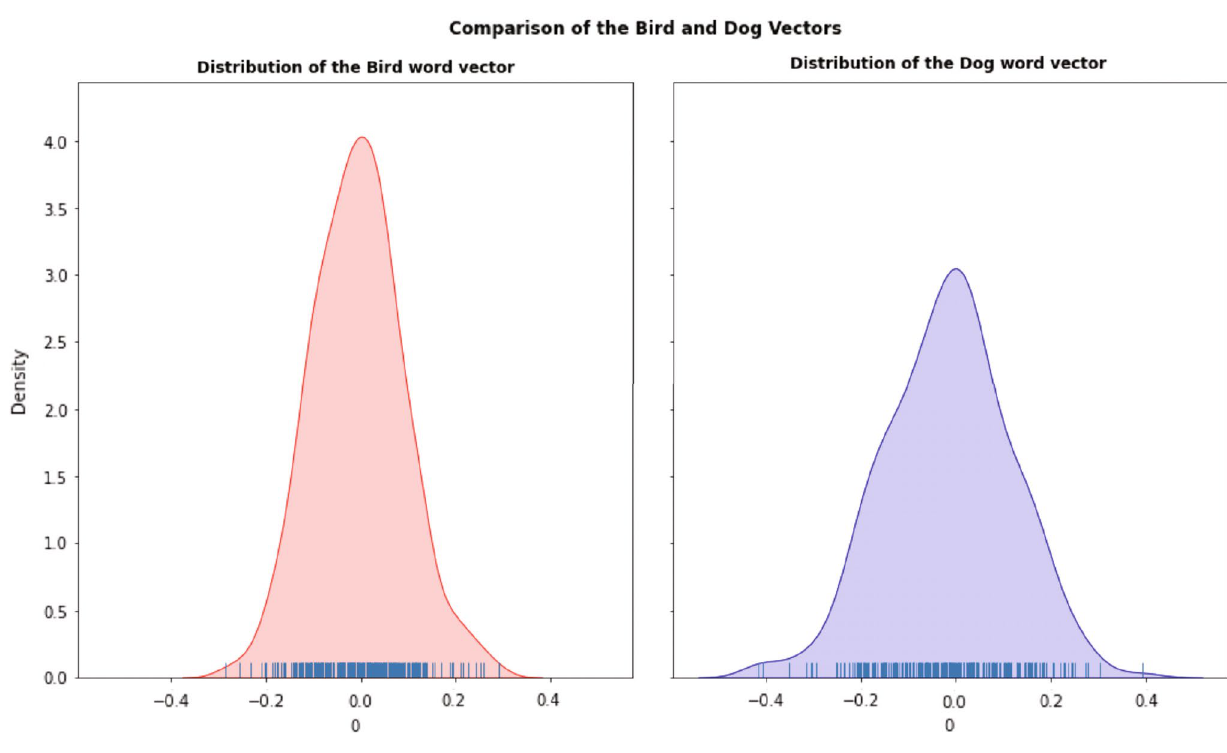
Fig. 11 Dog and bird word vectors Table 1 Top 10 nearest word vectors to ’bird’